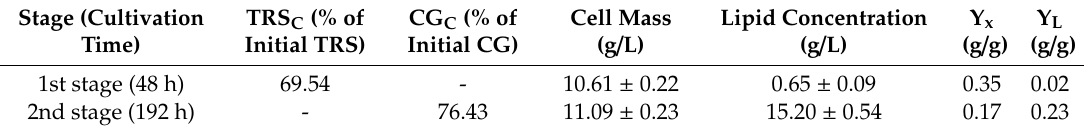
Table 5. Total reducing sugars consumption, glycerol consumption, cell mass yield, and lipid yield by R. fluvialis